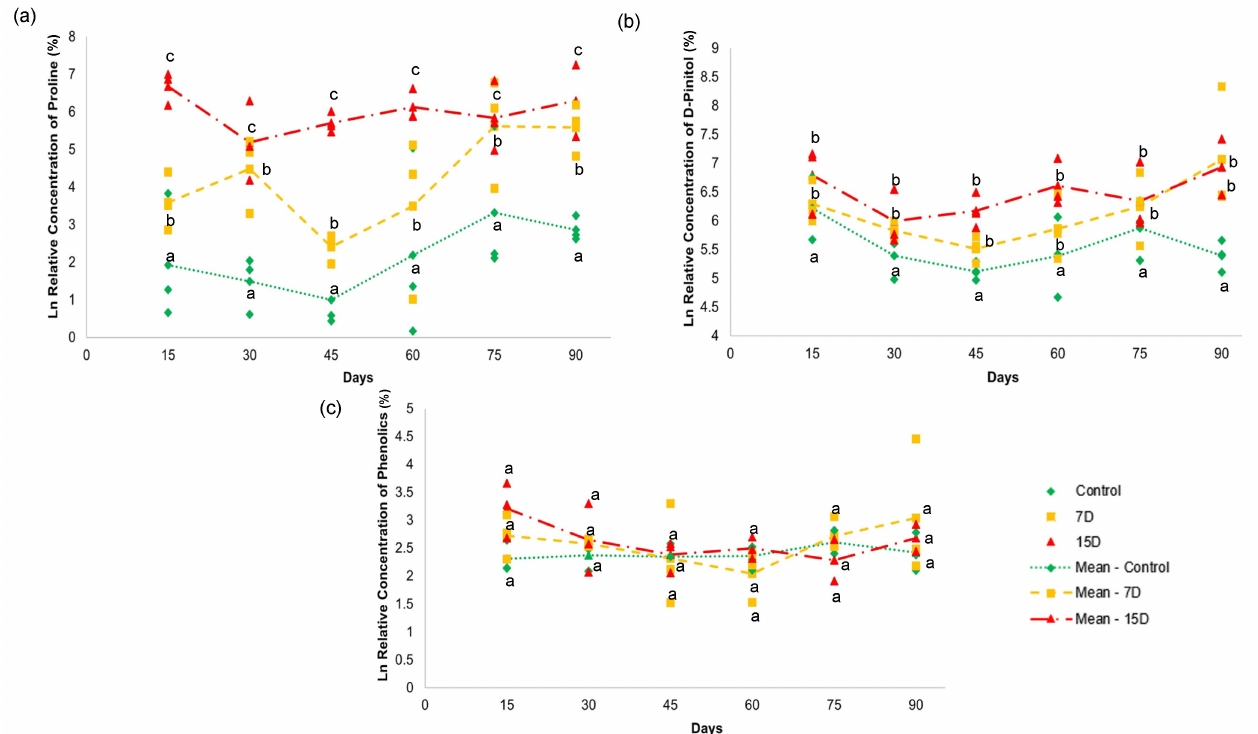
Figure 5. NMR quantitative analysis of ( a ) proline (22), ( b ) D-pinitol (25), ( c ) and total phenolics in the hydroalcoholic leaf extract of specimens of Bauhinia ungulata under daily irrigation (control—green), one irrigation every 7 days (7D—orange) and one irrigation every fifteen days (15D—red). The data are expressed as a log (ln) of the relative concentration of each compound. Different letters indicate significant difference ( p <